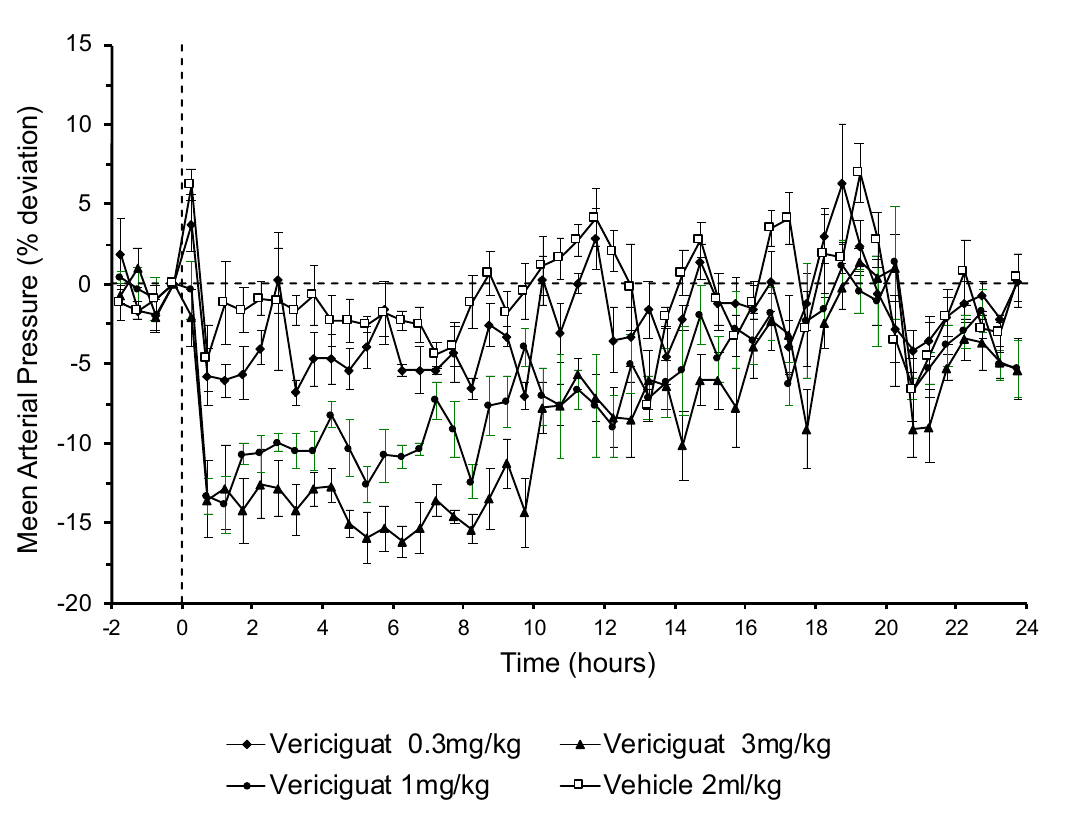
Figure 3. The effects of vericiguat on mean arterial blood pressure. Vericiguat induced a long-lasting drop in mean arterial blood pressure (MAP, % from baseline) after application of 1 or 3 mg/kg vericiguat (bolus p.o.). Data are represented as mean SEM (n = 4–5 in each group).